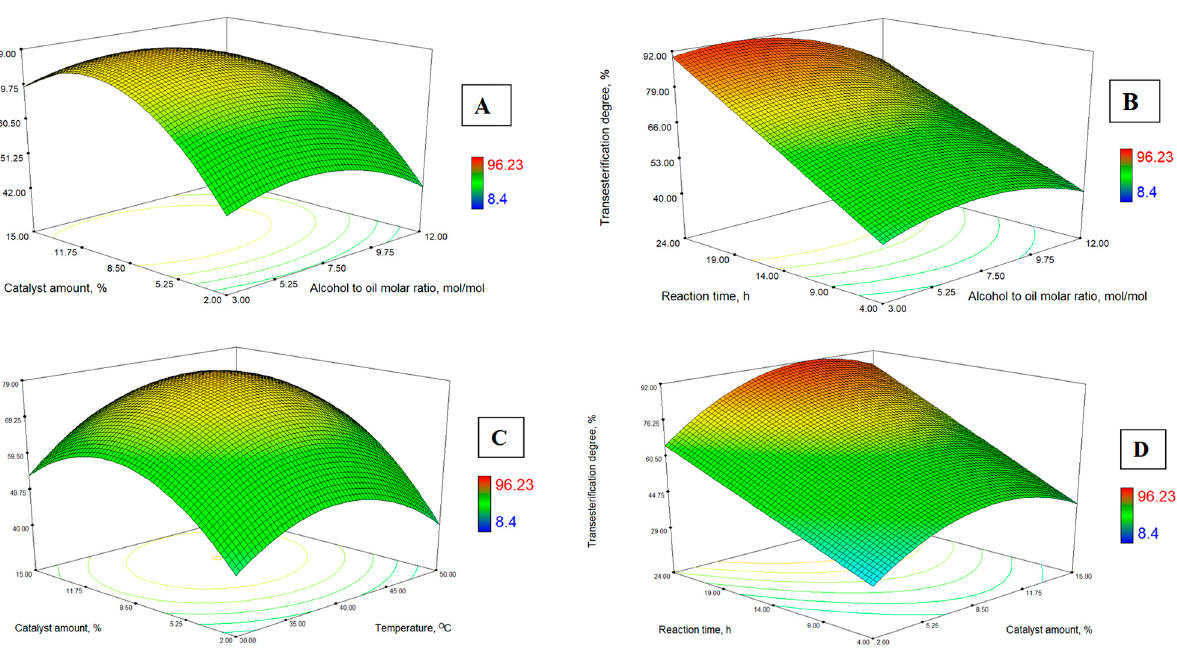
Figure 2. Correlation of actual and predicted values for transesterification yield.